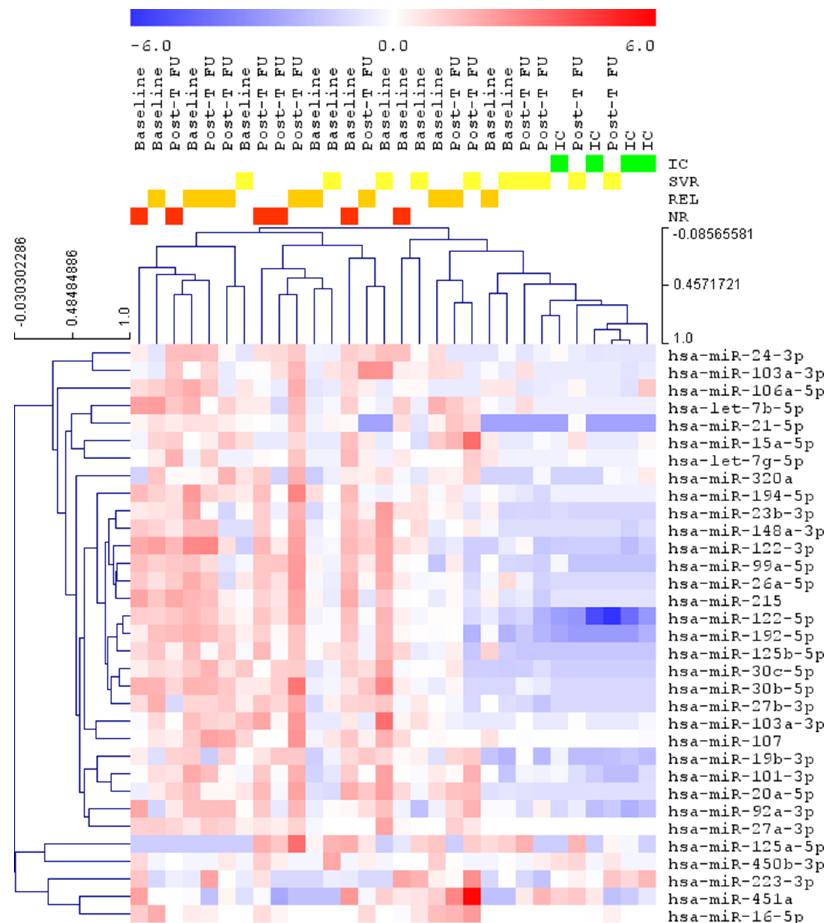
Figure 1. Hierarchical clustering of miRNAs from HBsAg particles and samples. The heatmap shows the result of the two-way hierarchical clustering of miRNAs from HBsAg particles and samples (zero centered). The colour scale shown at the top illustrates the relative expression level of a miRNA across all samples: red colour represents an expression level above mean, blue colour represents expression lower than the mean. The SVR post-T FU (Peg-IFN treated patients) group clusters with the IC group.